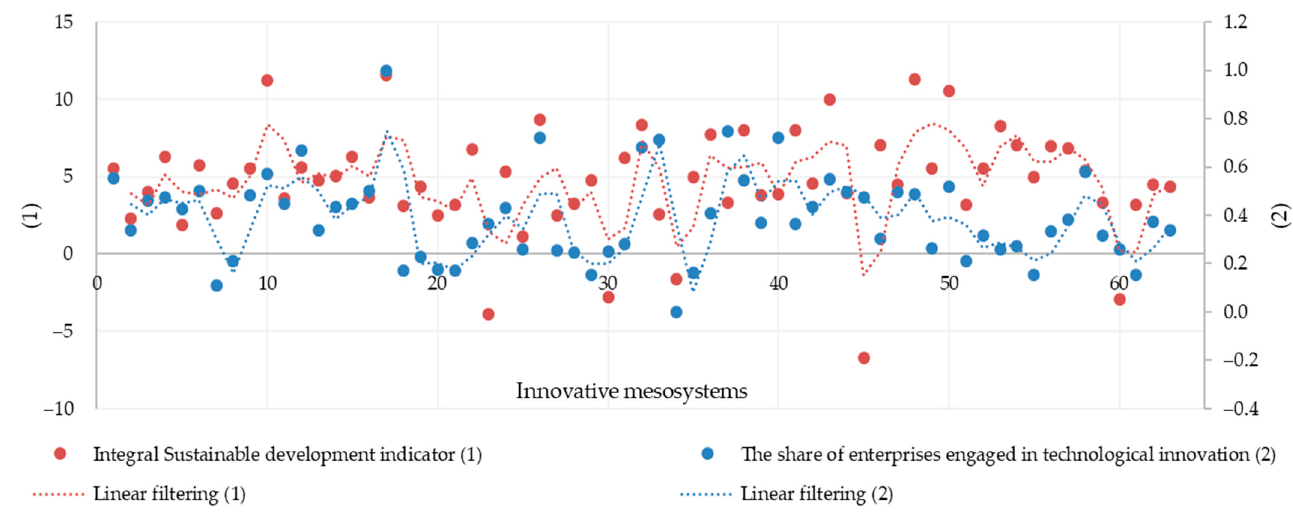
Figure 2. Deviation schedule.